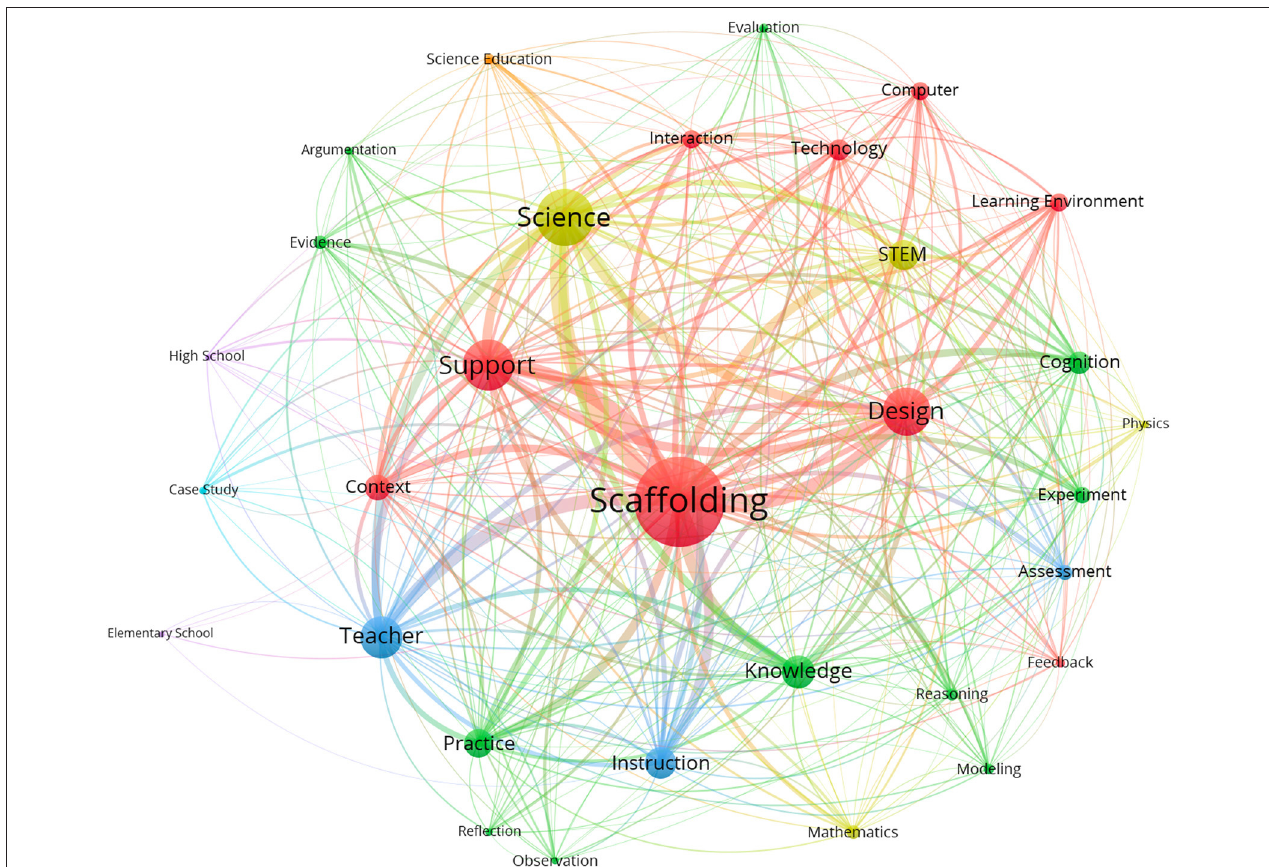
FIGURE 5 | The co-occurred network of scaffolding research (All period: 2000–2019, keywords = 31).